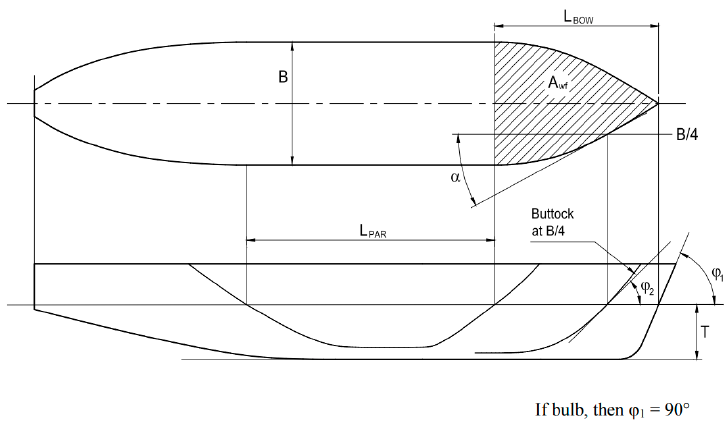
Figure 1. Characteristic parameter value.